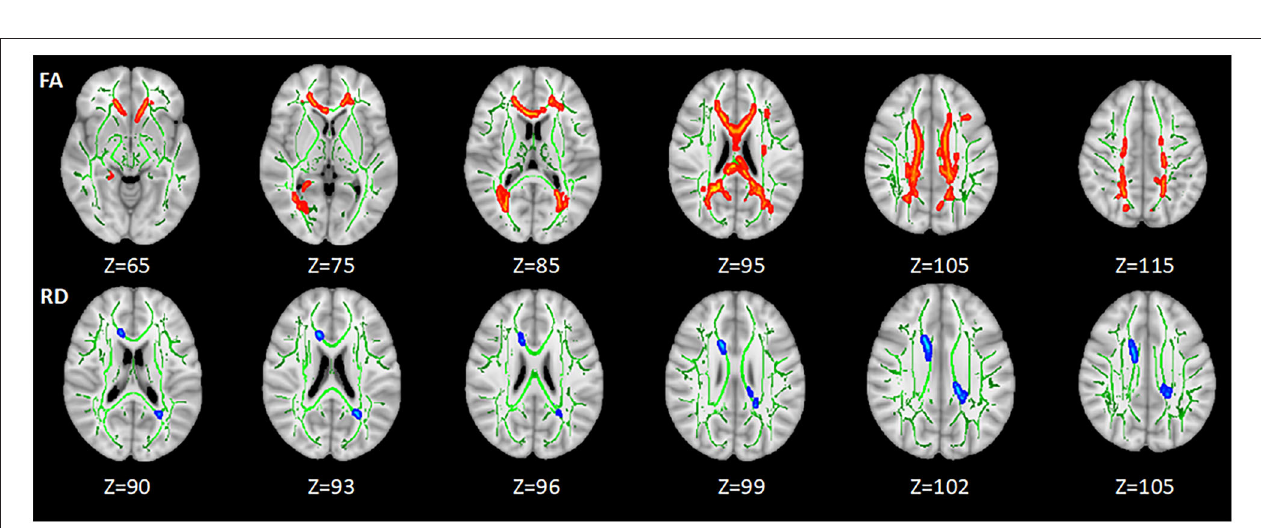
FIGURE 2 | The differences of DTI measures between healthy controls and HIV + /syphilis + group. Areas in red represent brain regions with significant lower FA in the HIV + /Syphilis + group compared with healthy controls. Areas in blue represent brain regions with significant higher RD in the HIV + /Syphilis + group compared with healthy controls (FWE-corrected p < 0.05). Green represents mean white matter skeleton of all subjects. The number below each brain image indicates the Z coordinate in the MNI space.